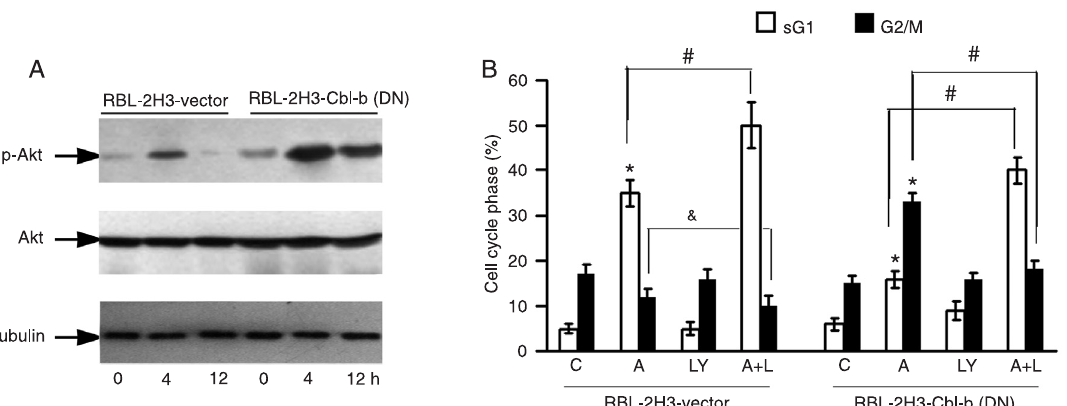
Figure 4. Modulation of phospho-Akt (p-Akt) level by arsenic trioxide. A , Total proteins or the proteins in the cytosolic frac- tions were isolated and p-Akt and Akt levels were measured by Western blotting. B , Frequency of apoptotic cells and G2/M phase cells in untreated cultures, and in cultures treated with 25 μM arsenic trioxide (A) and/or 25 μM LY294002 (LY) for 12 h. The experiments were repeated at least three times. Differences between two groups were determined by the Student t -test. *P < 0.05 compared to control (C) cells; # P < 0.05 for comparison between the two groups indicated. & P = 0.057 for comparison between the two groups